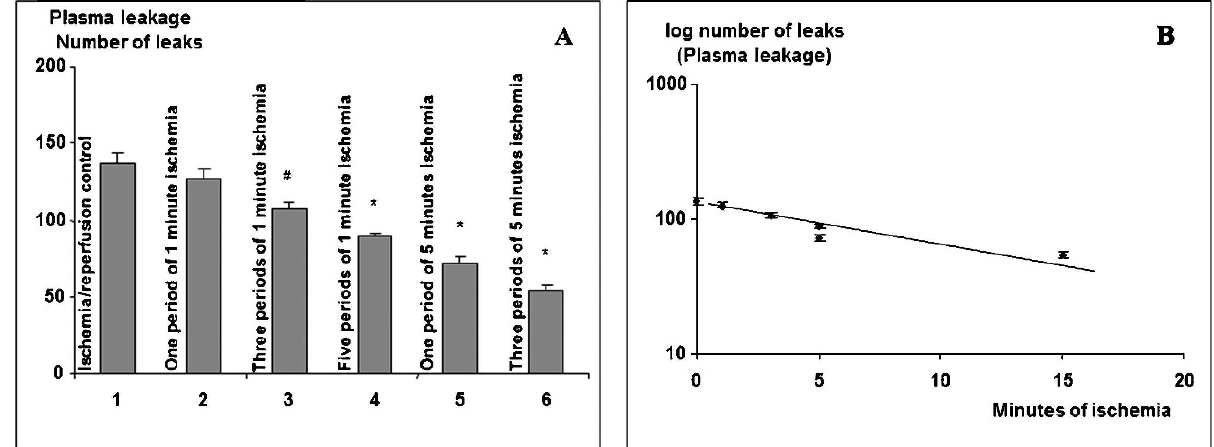
Figure 3 - Effect of brief periods of ischemia and reperfusion prior to a period of 30 minutes of ischemia. A. Plasma leakage (maximal number of leaks ¡ SD) induced at reperfusion after 30 minutes of ischemia following brief periods of ischemia/reperfusion in six groups of hamsters (each group, n=6) prior to the final 30 minute-ischemic period. # = p , 0.05, *= p , 0.01 as compared with I/R controls. B . Log-linear relationship between the number of leaks and the total ischemic period prior to the final 30 min I/R.